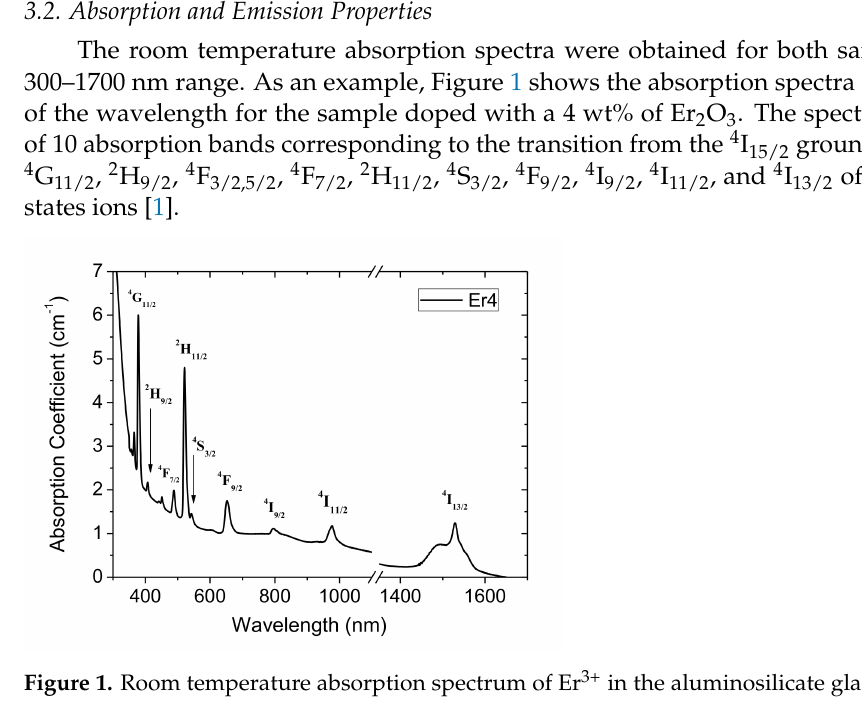
Figure 1. Room temperature absorption spectrum of Er 3+ in the aluminosilicate glass doped with 4 wt% Er 2 O 3